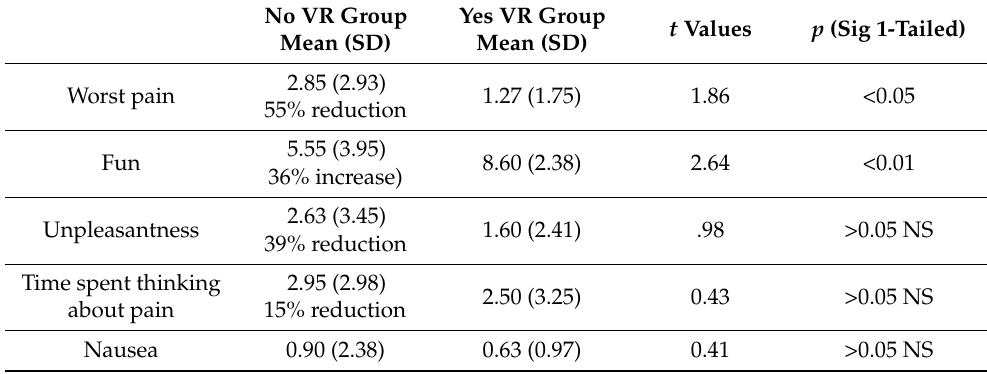
Table 3. (Ages 7–11). Pain, fun, and nausea mean levels in the experimental and control group.